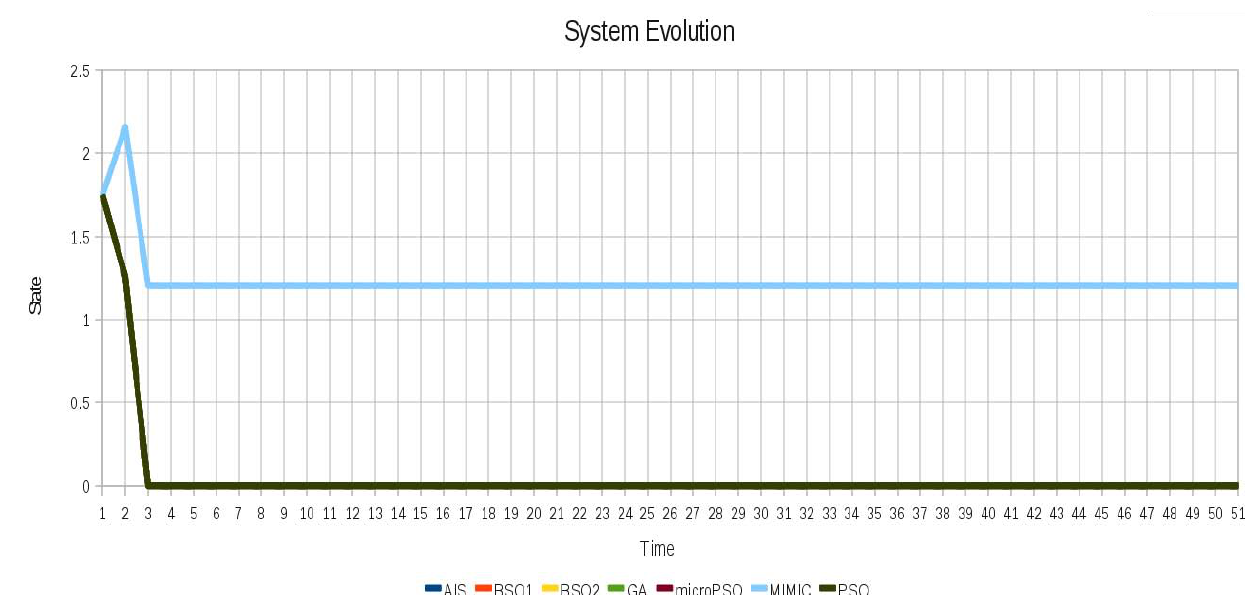
Figure 7. Instabilities are successfully removed for instance 1 (Blinker) using all